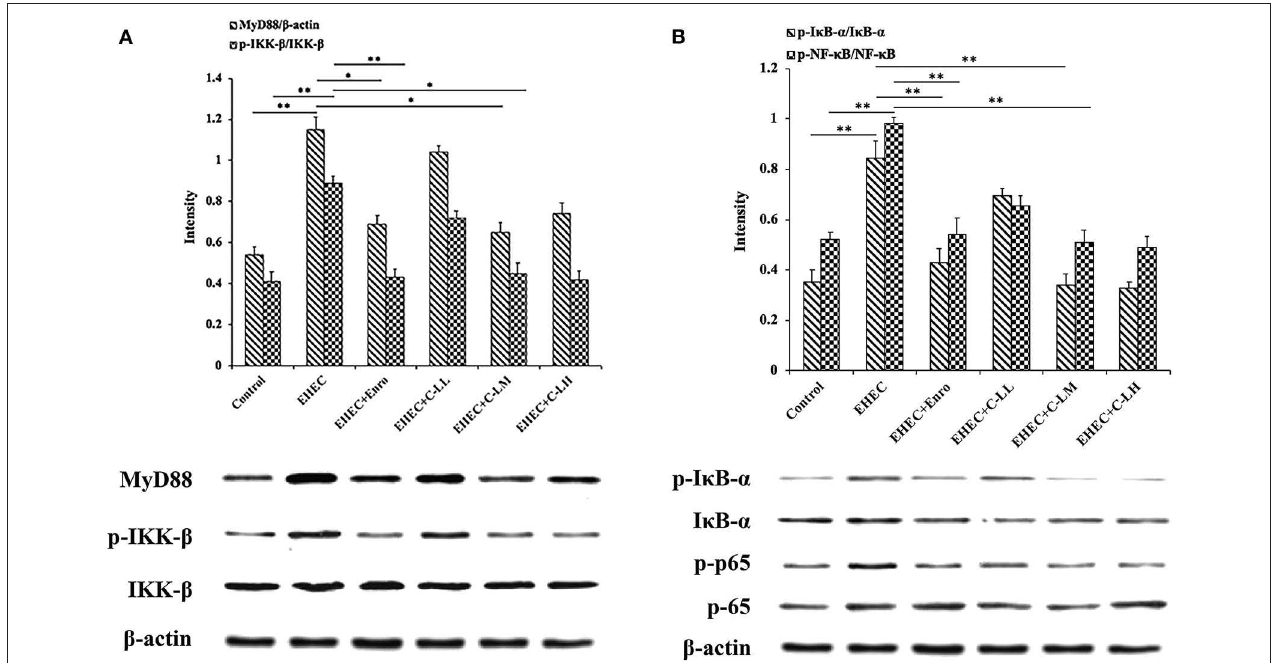
FIGURE 6 | C-L inhibited the NF- κ B (p65)-signaling pathway in mouse jejunum tissues. The same control image is used in the left (A) and right (B) columns. The control group was orally administered 100 µ L sterile PBS; the EHEC group was orally administered 100 µ L sterile PBS containing 1 × 10 8 CFUs EHEC O157:H7; the EHEC + Enro group was orally administered 100 µ L sterile PBS containing 1 × 10 8 CFUs EHEC O157:H7 and then treated by i.p. injection with 8 mg/kg Enro once/day for 3 days; the EHEC + C-LL, EHEC + C-LM, and EHEC + C-LH groups were administered 100 µ L sterile PBS containing 1 × 10 8 CFUs EHEC O157:H7